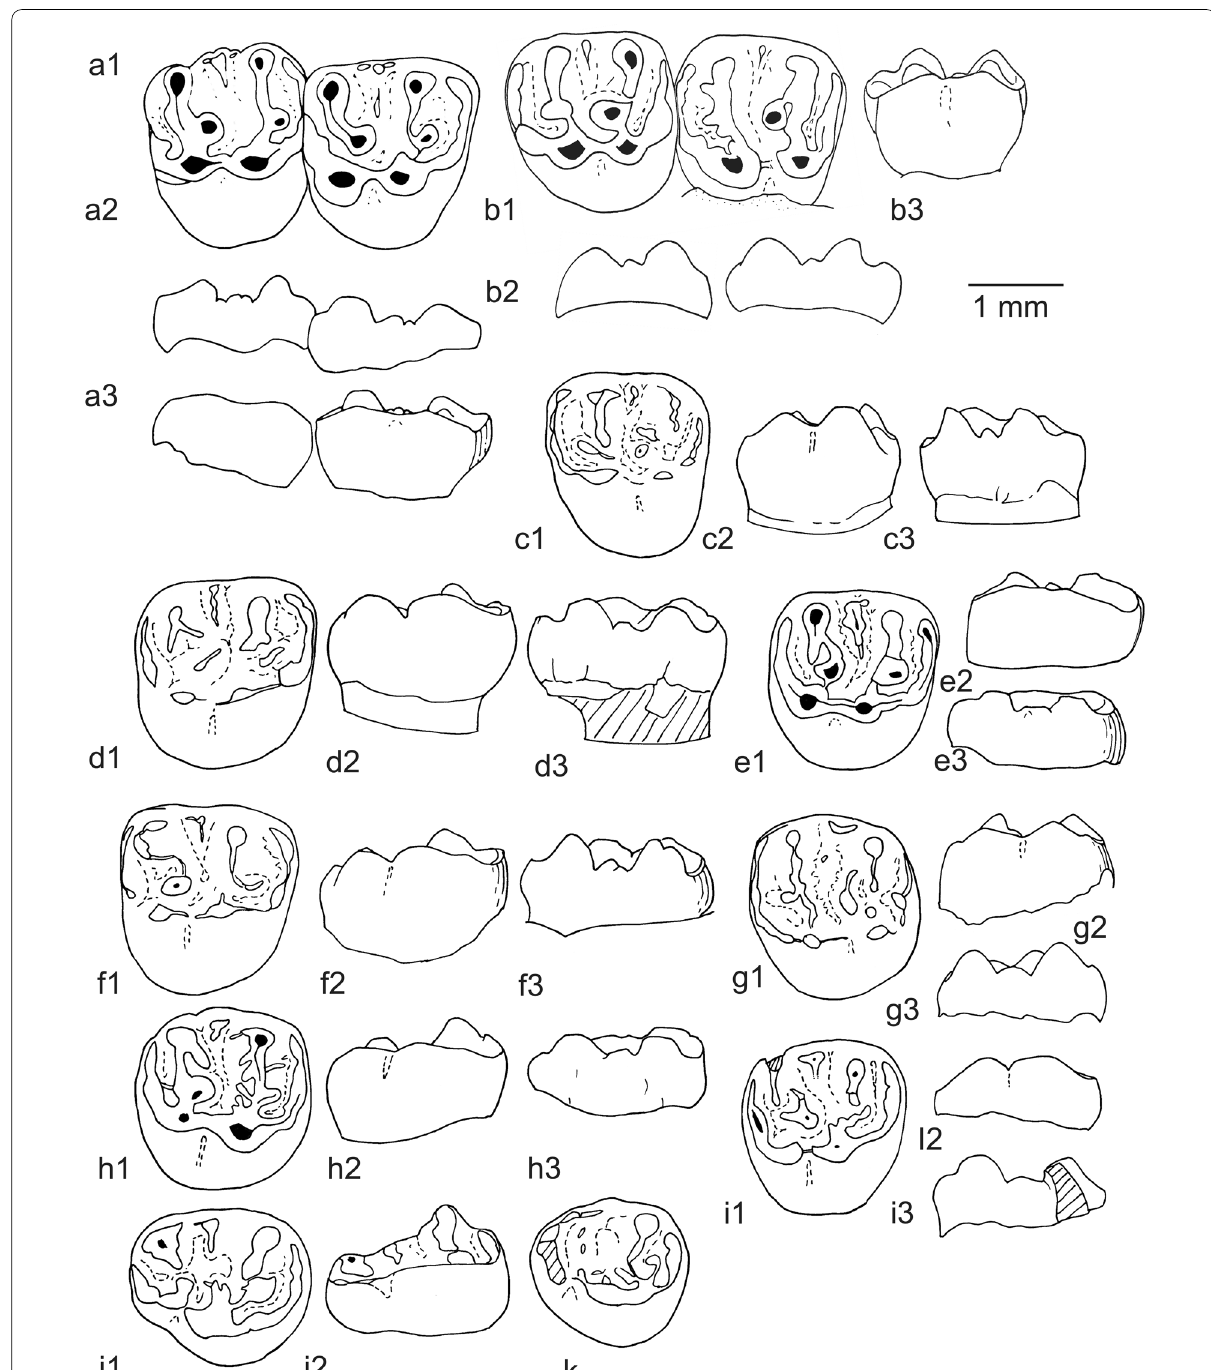
Fig. 7 Upper teeth of Protadelomys cartieri (Stehlin & Schaub, 1951), from Egerkingen (Swiss Jura). a Eg 596, right M1–M2; a1, occlusal view; a2, buccal aspect; a3, lingual aspect. b Ek 249, left M1–M2; b1, occlusal view; b2, buccal aspect; b3, lingual aspect of M1. c Ek 87, left M1, nearly unworn; c1, occlusal view, c2: lingual aspect; c3, buccal aspect. d Ek 45, right M1, nearly unworn; d1, occlusal view; d2, lingual aspect; d3, buccal aspect. e Ek 125, right M1, moderately worn; e1, occlusal view; e2, lingual aspect; e3, buccal aspect. f Ek 124, right M1, nearly unworn; f1, occlusal view; f2, lingual aspect; f3, buccal aspect. g Ek 86, left M2, nearly unworn; g1, occlusal view; g2, lingual aspect; g3: buccal aspect. h Ek 87, right M2, weakly worn; h1, occlusal view; h2, lingual aspect; h3, buccal aspect. i Ek 88, right M2, weakly worn; i1, occlusal view; i2, lingual aspect; i3, buccal aspect. j Ek 46, right M3, weakly worn; j1, occlusal view; j2, lingual aspect. k Ek 84, right M3, occlusal view. Scale bar: 1